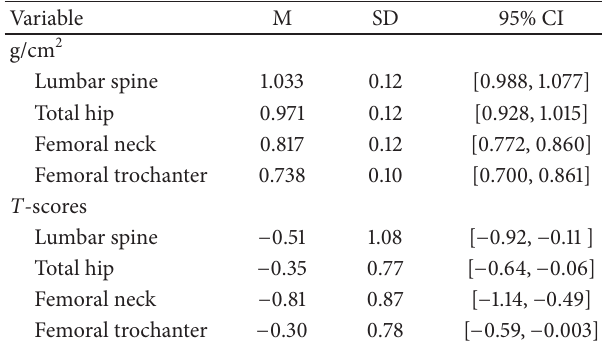
Table 2: Means, standard deviations, and 95% confidence intervals for BMD ( 𝑁 = 30